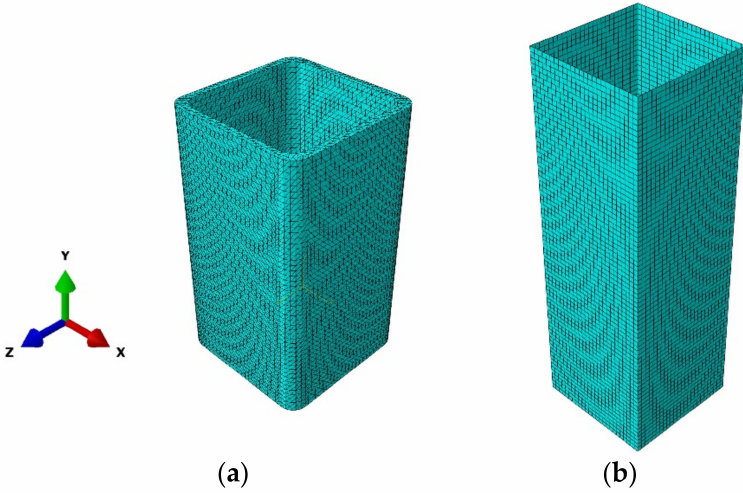
Figure 8. Finite-element resolution for ( a ) FRCM and ( a )